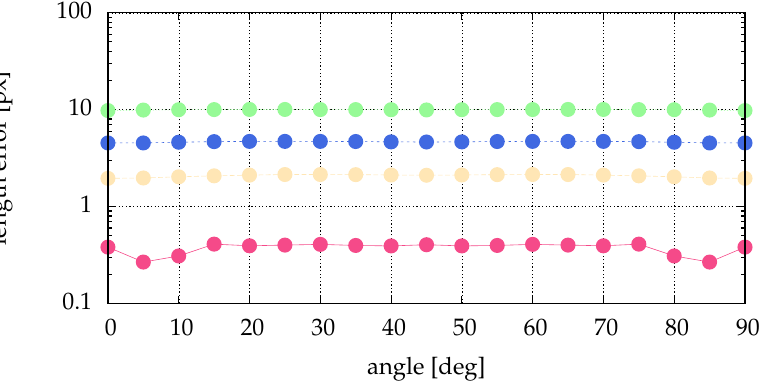
Figure 13. Comparison of length errors for different angles of the stripe and different particle sizes: pink ( (cid:4) ) for σ = 0.1, yellow ( (cid:4) ) for σ = 0.5, blue ( (cid:4) ) for σ = 1 and green ( (cid:4) ) for σ = 2. To overcome the dependence on the subpixel position shown in Figure 10 we averaged over 100 equally destributed subpixel positions. The length was varied between 1 px and 21 px in 11 equal steps. This means, every plotted length error is an average of 1100 analyzed artificial stripes. The scale of the ordinate is